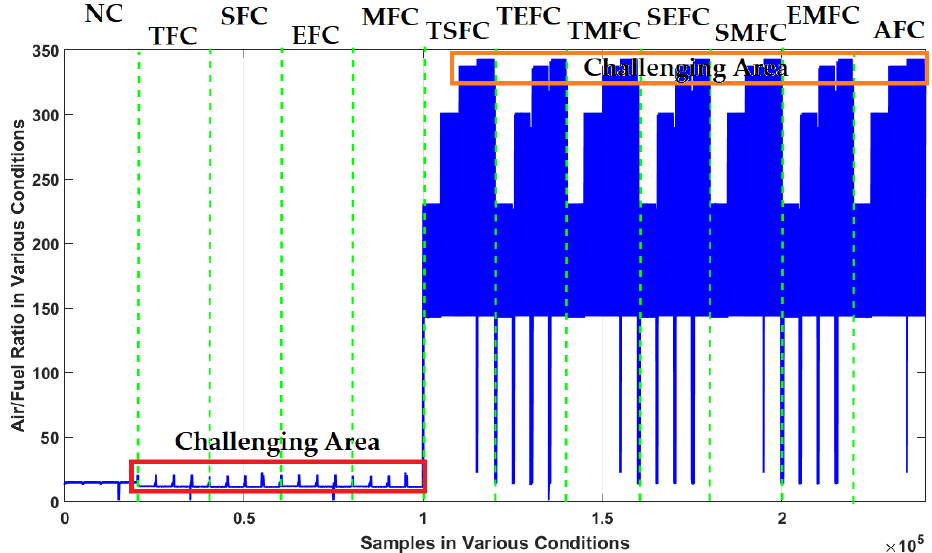
Figure 3. Air-to-fuel-ratio signal when sensors operate in normal and abnormal conditions.